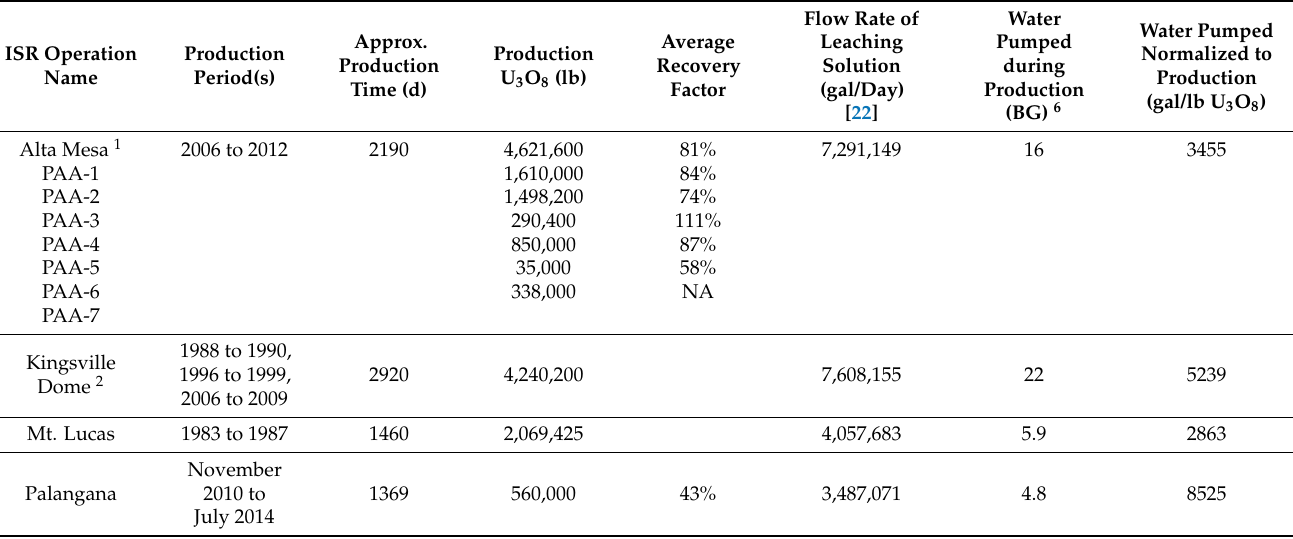
Table A1. Overview of the six ISR operations completed in the Goliad Sand in the Texas Coastal Plain examined in this